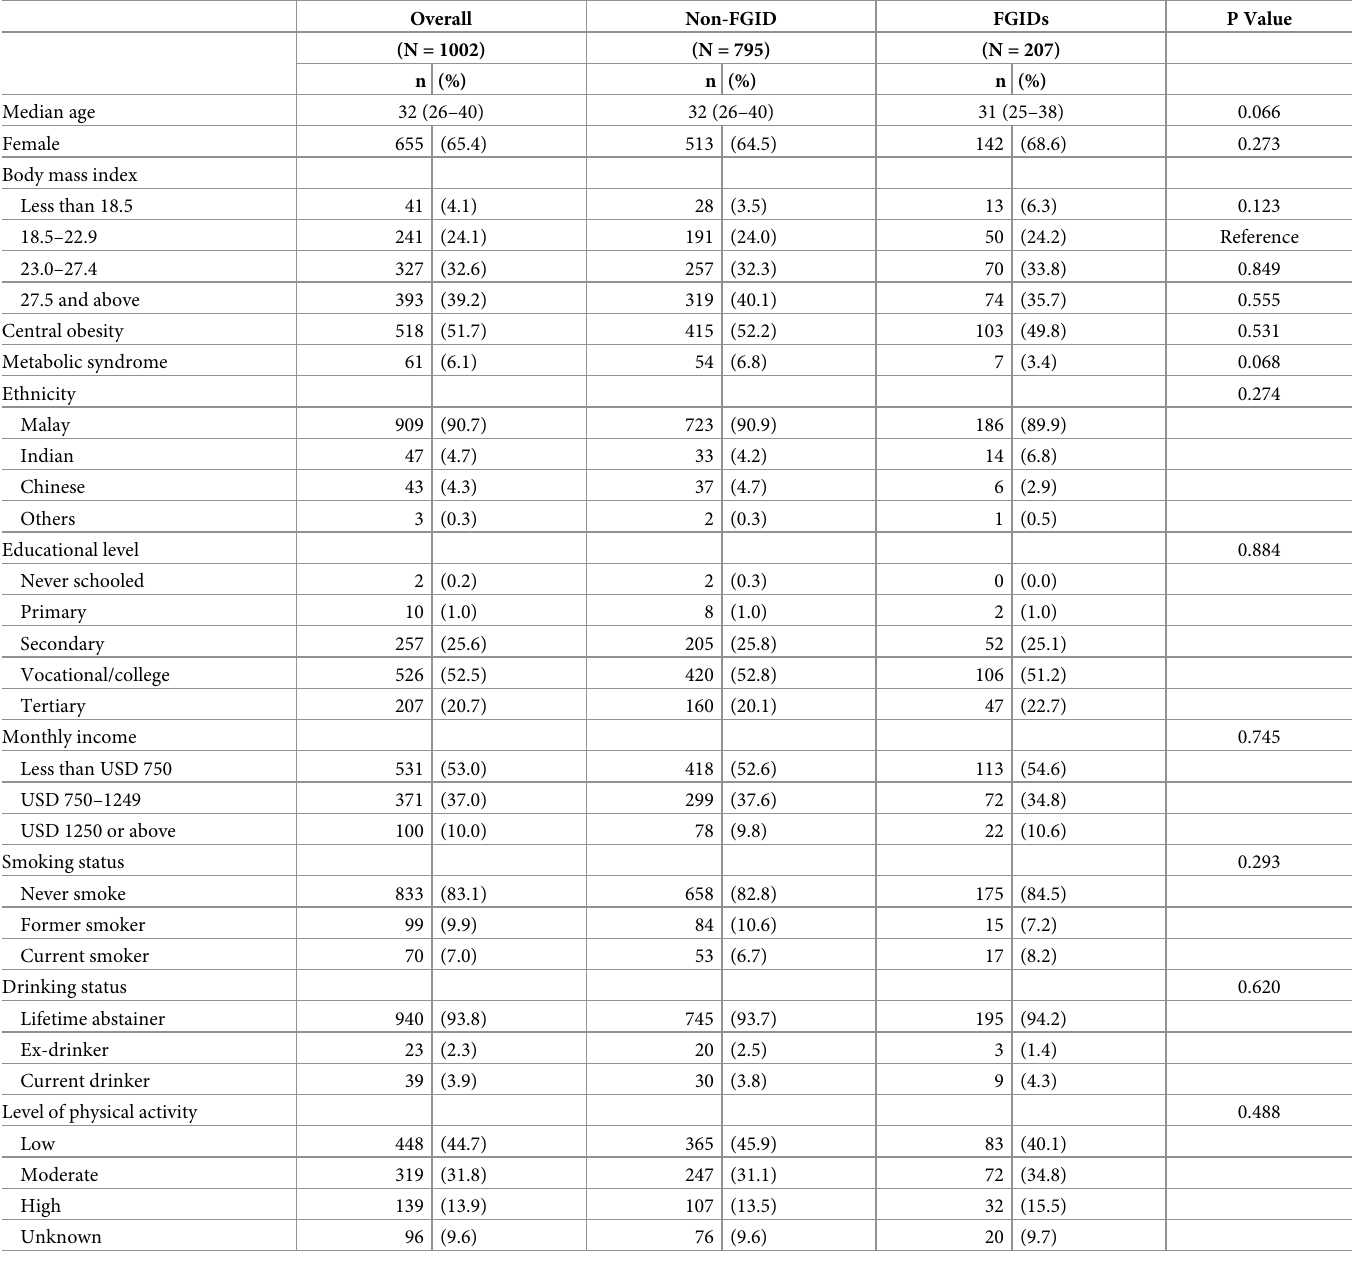
Table 1. Characteristics of study